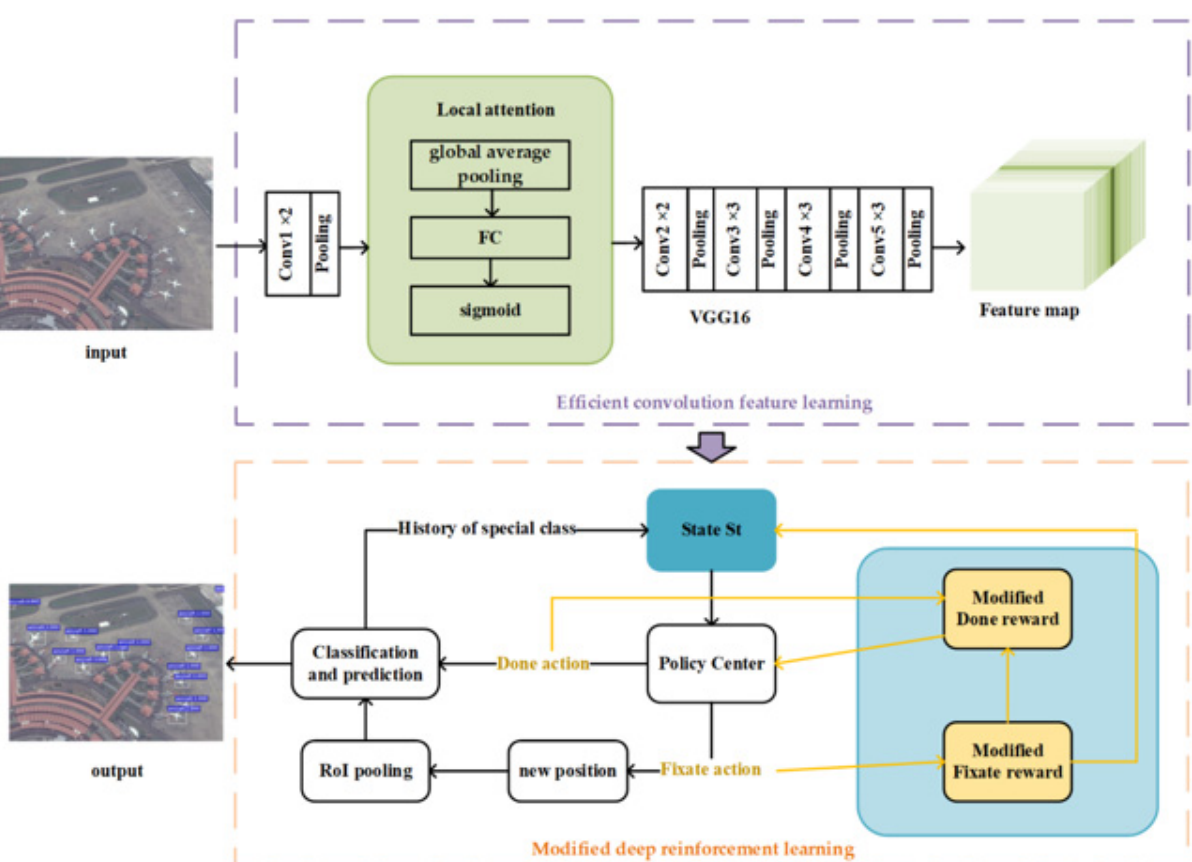
Figure 1. The overall framework of the proposed MdrlEcf model, including efficient convolution feature learning and modified deep reinforcement learning. The green part represents the local attention added to VGG16 and the integrated feature map. The purple rectangular is the efficient convolution feature learning, and the orange rectangular represents the modified deep reinforcement learning (DRL). The yellow line is the modified reword functions utilized in MdrlEcf.